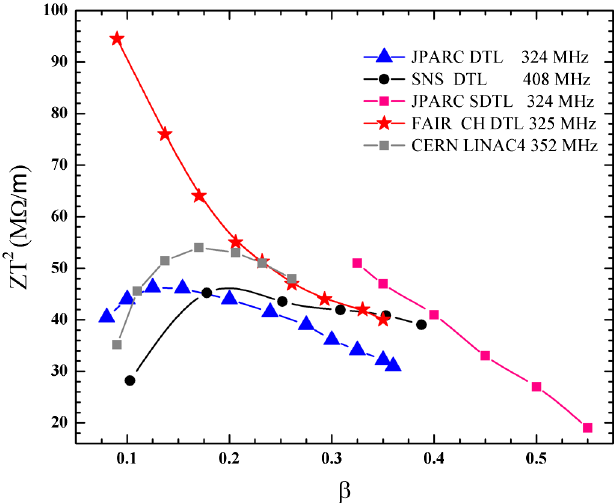
FIG. 6. A comparison of the effective shunt impedance of recent proposed and built DTL’s.